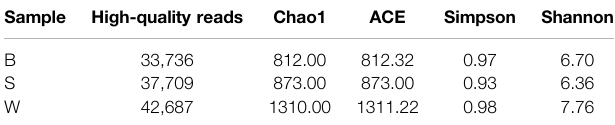
TABLE 3 | Effective reads and alpha diversity index of three samples.